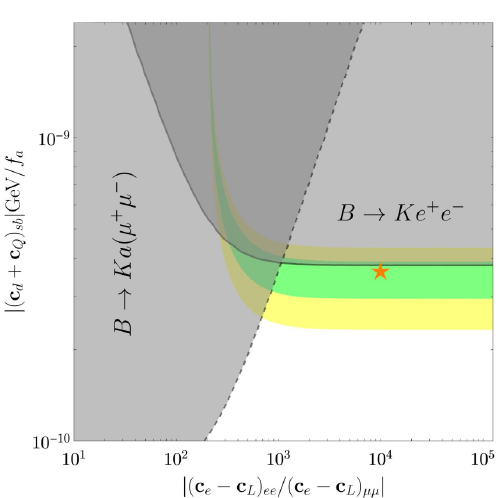
Figure 6. ALP mass within the central bin range. Constraints from semileptonic B -decays on the parameter space of ALP couplings to quarks and leptons. In grey the excluded regions, while in green (yellow) the solutions to R at 1 σ ( 2 σ ). The orange star corresponds to the illustrative K benchmark point m = 1 . 2 GeV with ( | ( c ) ( c ) ) = (10 − 1 , 10 − 5 ) GeV − 1 a e − c L ee | /f a , | e − c L µµ | /f a